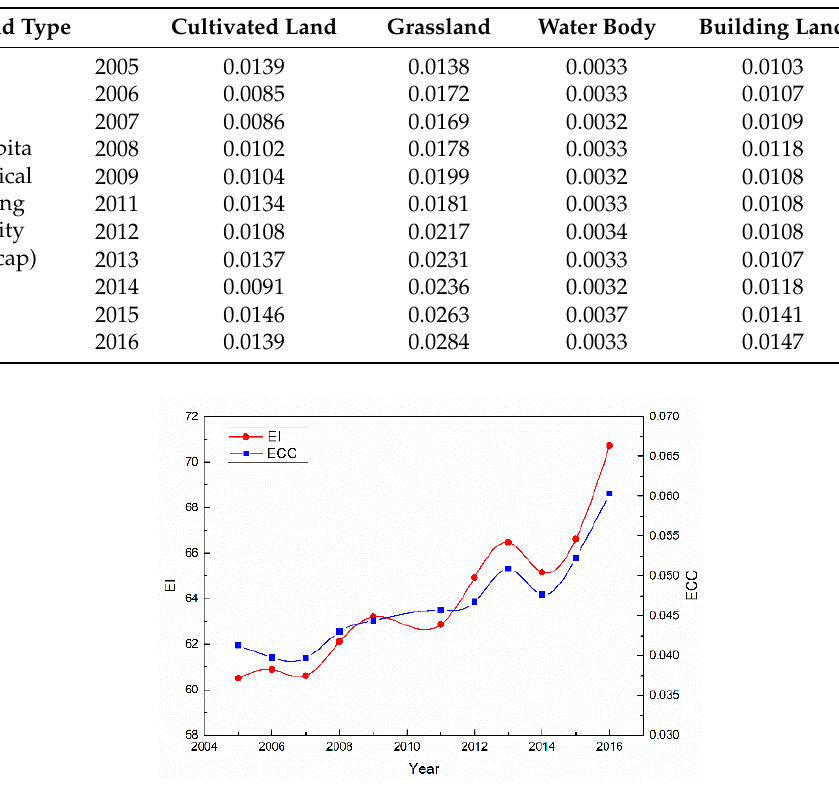
Table 12. Computational results of the per capita ecological carrying capacity of the study area.